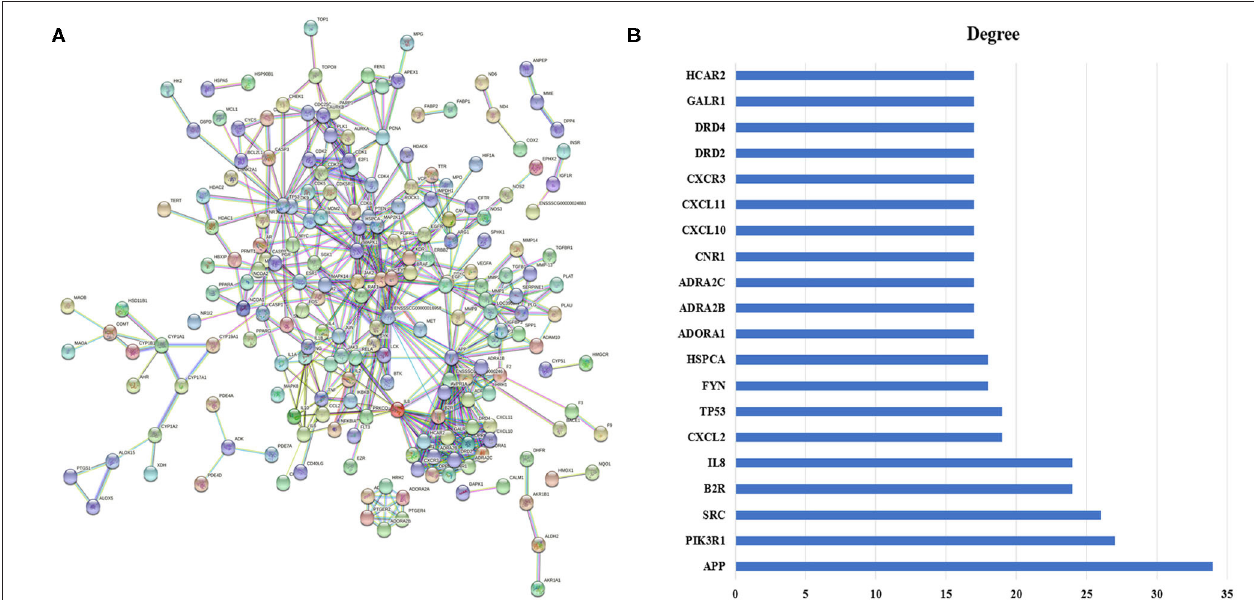
FIGURE 4 | Protein–protein interaction (PPI) network and its top 20 genes. (A) PPI network: The node represents the relevant gene, and the line width of the edge indicates the strength of the data support. (B) The top 20 genes of the PPI network: X-axis represents degree, and Y-axis indicates genes.